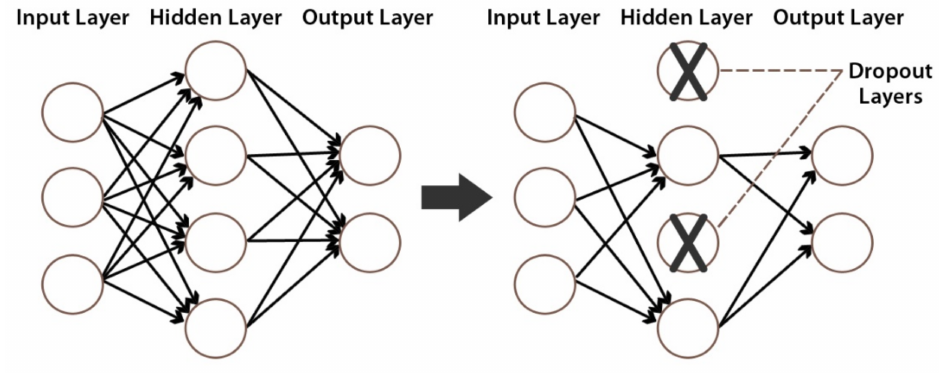
Figure 10. An example of a drop-out layer with a 50% drop-out probability.